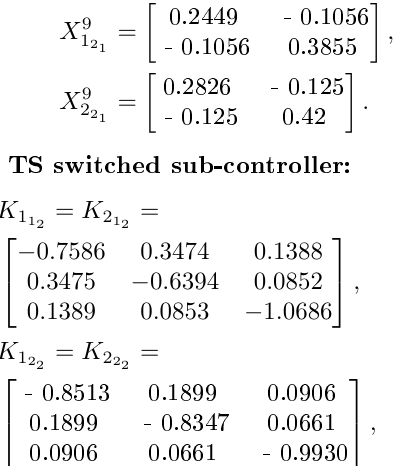
Fig. 3: Control signal and switched laws’ evolutions of the (cid:28)rst subsystem.